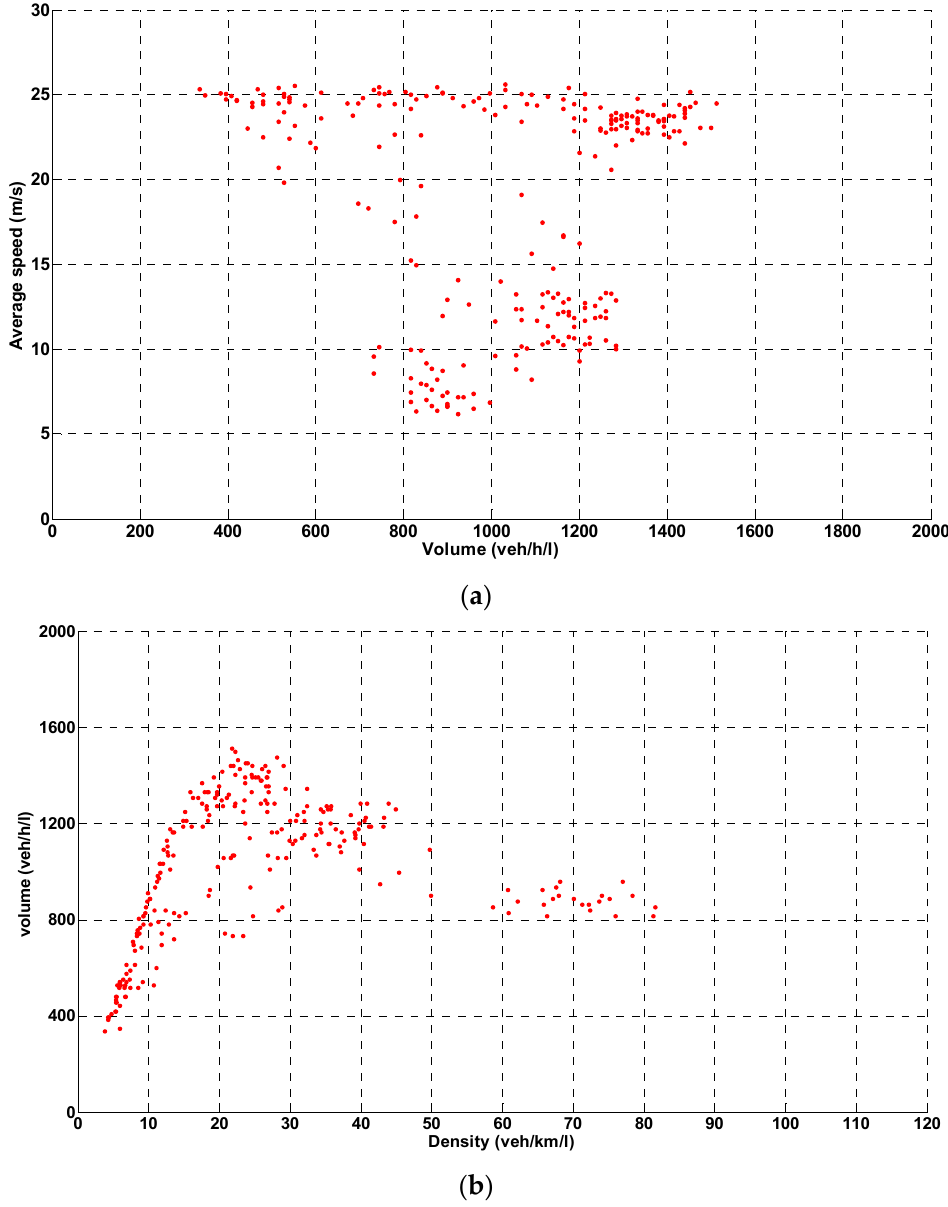
Figure 3. ( a ) Speed-flow diagram obtained from a simulation using the SBM CF model. ( b ) Flow- density diagram obtained from a simulation using the SBM CF model.